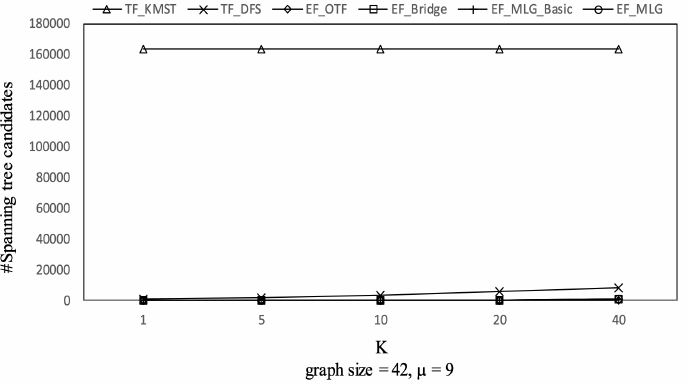
Figure 14. Spanning tree pruning on GraphGen vs. k with graphsize = 42 and µ = 9.